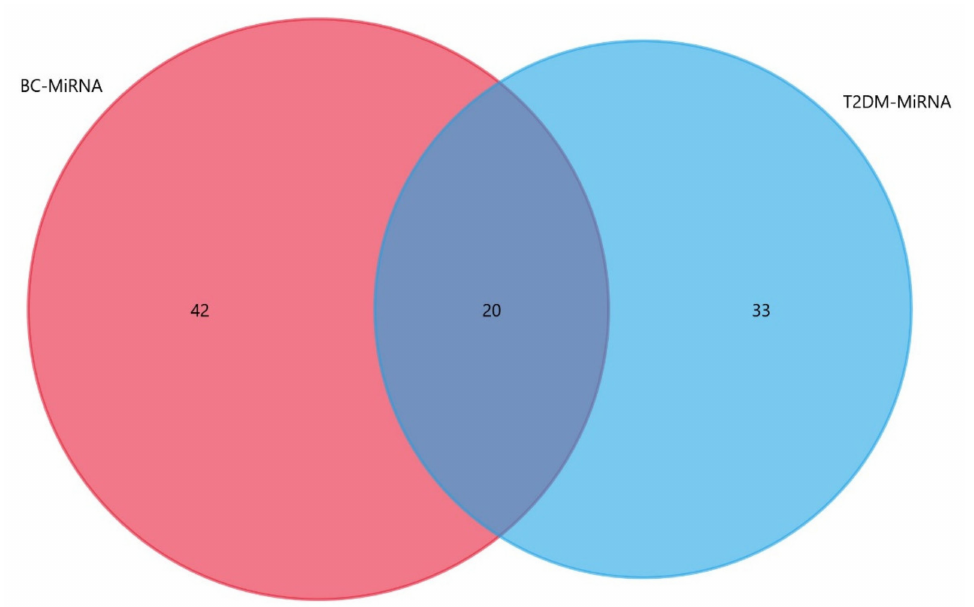
Figure 2. Signature miRNA overlap between T2DM and BC regulatory miRNA Networks. Each circle represents a disease-specific miRNA subset, with the intersection representing a signature of 20 miRNAs that are common to both T2DM and breast